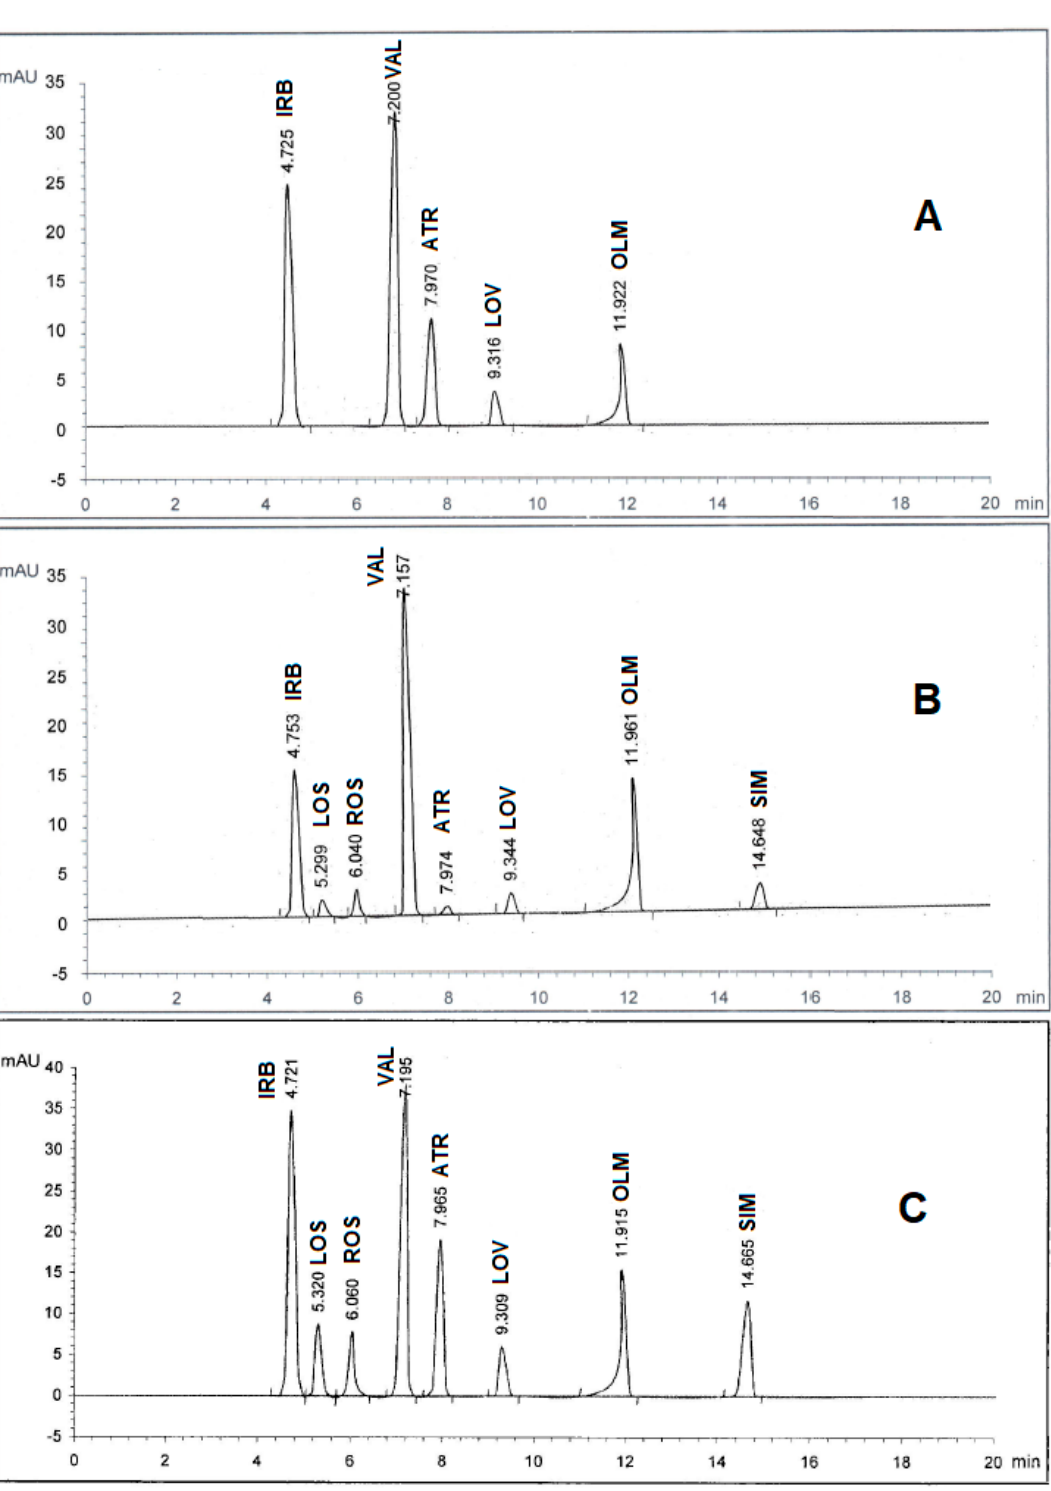
Figure 2. HPLC chromatogram of authentic mixture containing irbesartan (IRB), losartan (LOS), rosuvastatin (ROS), valsartan (VAL), atorvastatin (ATR), lovastatin (LOV), olmesartan (OLM), and simvastatin (SIM) using a Kinetex C 18 100A column (2.60 μ m, 4.60 mm × 100 mm) and a gradient mobile phase 0.05M potassium dihydrogen phosphate buffer (pH 3.50 adjusted by ortho-phosphoric acid) and acetonitrile at different wavelengths: ( A ) 230 nm, ( B ) 254 nm, and ( C ) 280 nm. Other chromatographic conditions are stated in Table 1.